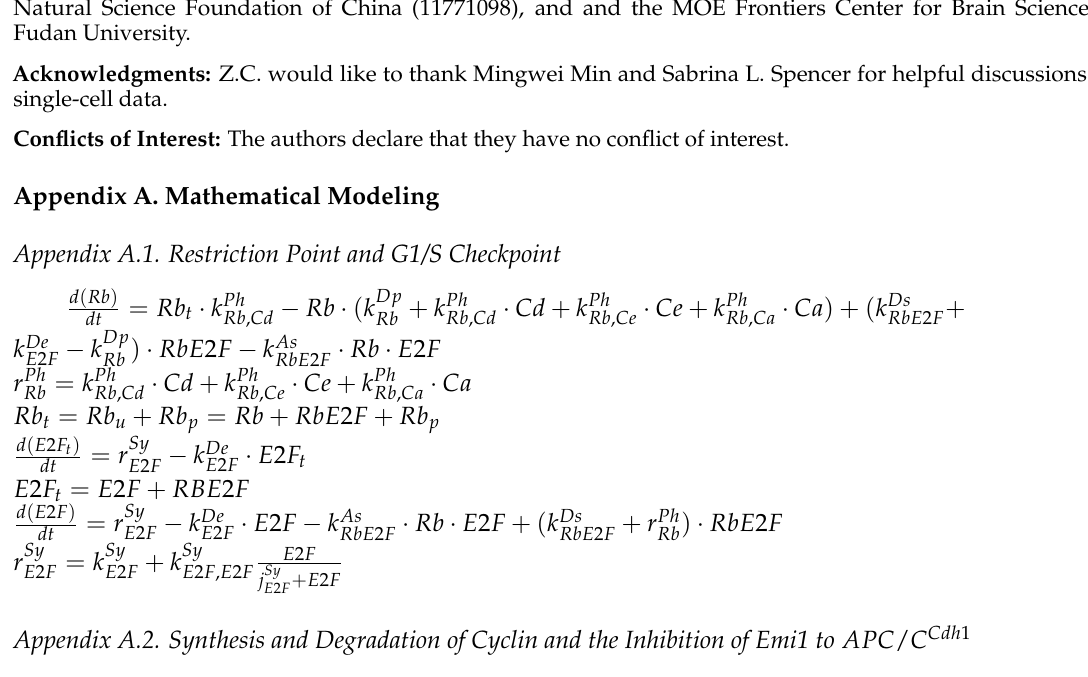
Table S1. Stable steady states for tristable system. Table S2. Random edge deletion. Table S3. Random edge reassignment. Figure S1. A complete influence diagram of the the early cell-cycle model. Figure S2. The landscape is displayed using different pairs of components. Figure S3. Cell quiescence-proliferation fate decision landscape. Figure S4. Single cell data supporting three stable cell states. Figure S5. Gap statistic results for the single cell data. Figure S6. Landscape changes as the synthesis rate of E2F changes. Figure S7. Landscape changes as the synthesis rate of Emi1 changes. kSyE1 is the synthesis rate of Emi1. Figure S8. Landscape changes as the concentration of Cdh1 changes. C1t is the total concentration of Cdh1. Figure S9. Landscape changes as the synthesis rate of CycA changes. kSyCa is the synthesis rate of CycA. Figure S10. Landscape changes as the synthesis rate of CycE changes. Figure S11. Effect of CycA (A–D) on the transition action (S) and barrier (U) between G0 and G1. Figure S12. Effect of CycA (A–D) on the transition action (S) and barrier (U) between G1 and S. Figure S13. Effect of CycE (A–D) on the transition action (S) and barrier (U) between G0 and G1. Figure S14. Effect of CycE (A–D) on the transition